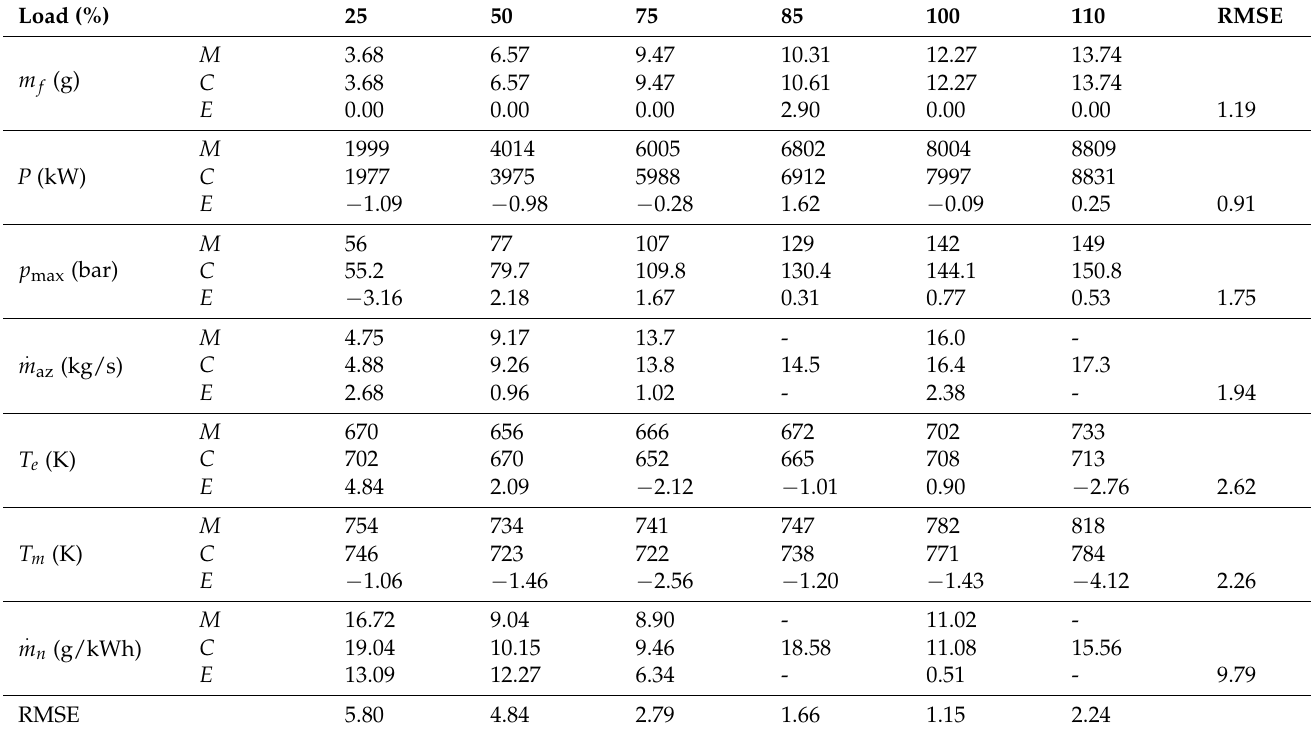
Table 5. The performance of the dual-fuel engine running in liquid fuel mode with the WA model.